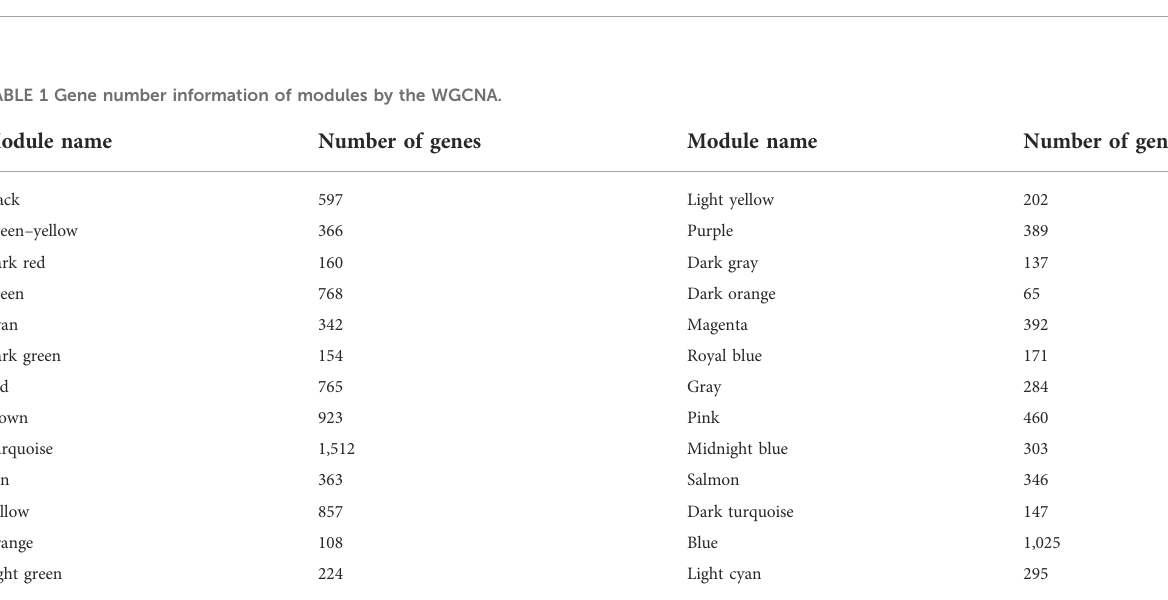
FIGURE 3 Identi fi cation of modules speci fi cally associated with LOD. (A) Cluster tree diagram and module feature relation diagram are used to divide modules. (B) Heatmap of the correlation between module characteristic genes and different stages. Each cell contains a speci fi c associated exponent and p -value. (C) Scatter diagram of genes in the blue module. (D) Scatter diagram of genes in the light cyan module.